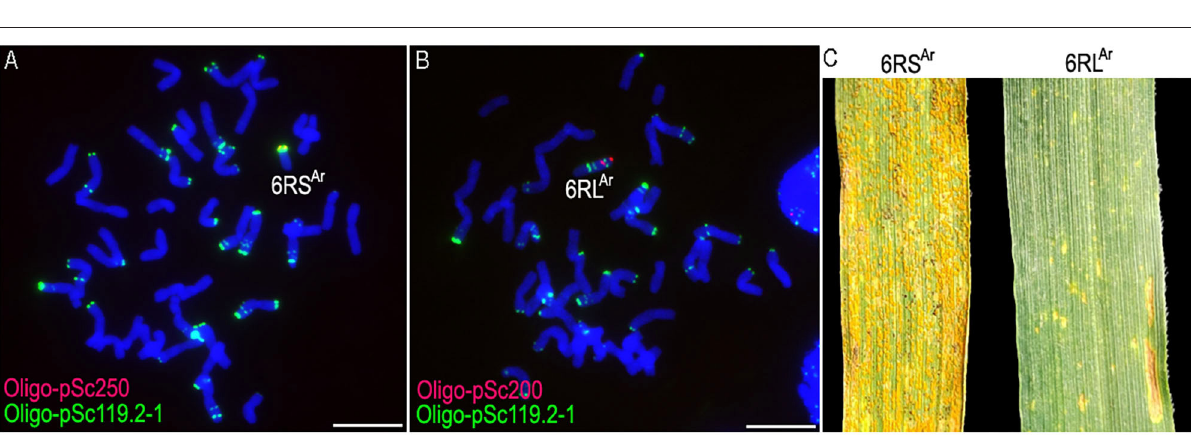
designing primer pairs. Primer pairs of P60 (5 ′ TGGGG AATAG CTGGC ATTGG3 ′ , 5 ′ TCGGT AGGGT AGACG GTGAG3 ′ ) and P70 (5 ′ AATGG GAGGA CTCTT GCGTG3 ′ , 5 ′